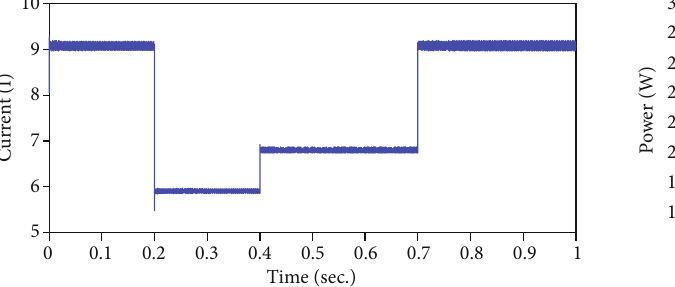
Figure 21: Output power of